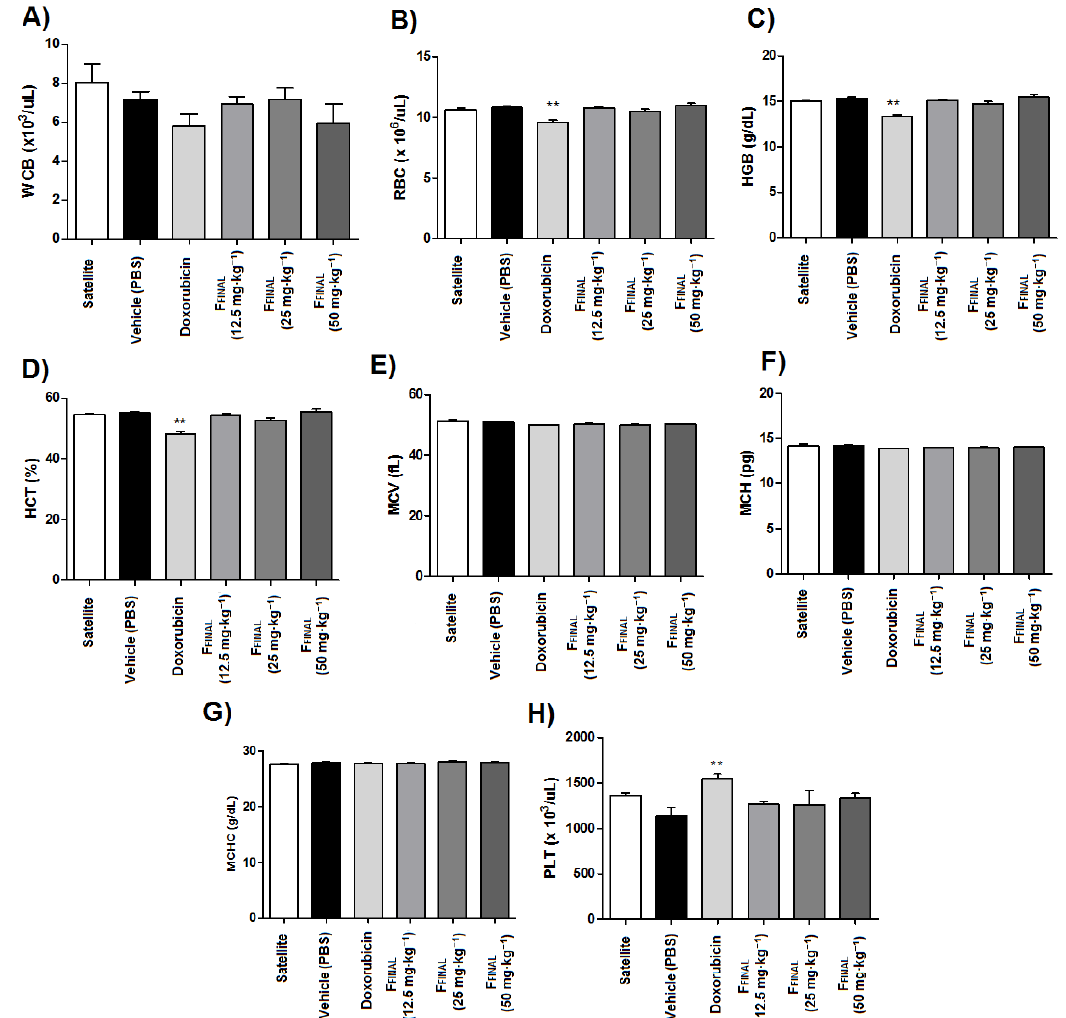
Figure 7. Blood cell count of animals from Ehrlich flank solid tumor experiment—F FINAL fraction. Results expressed as mean ± standard error; Female Balb / c mice ( n = 8 animals / group); Treatments